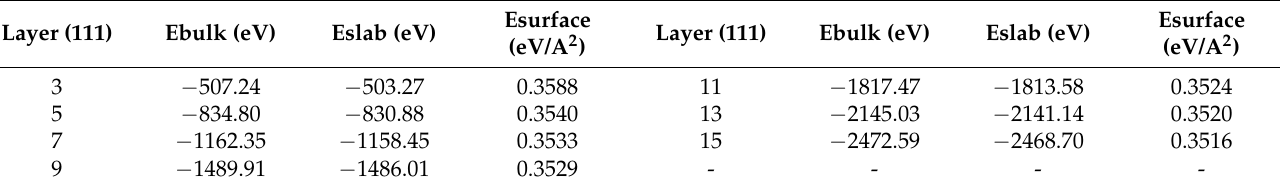
Table 1. H-terminated diamond (111) surface 3–15 layer surface